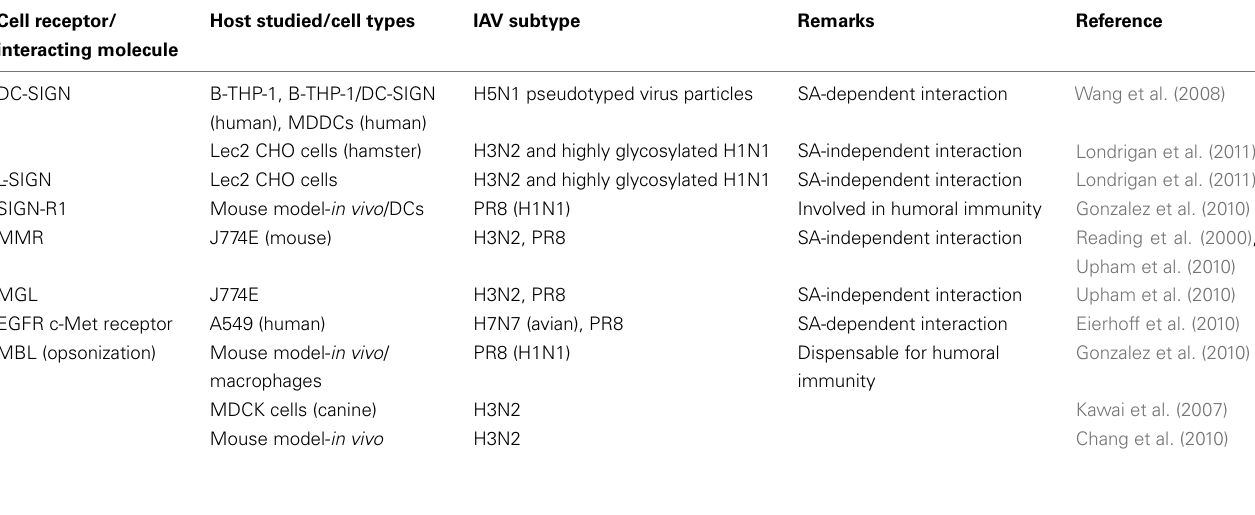
Table 1 | Summary of cell surface or soluble host molecules reported to interact with